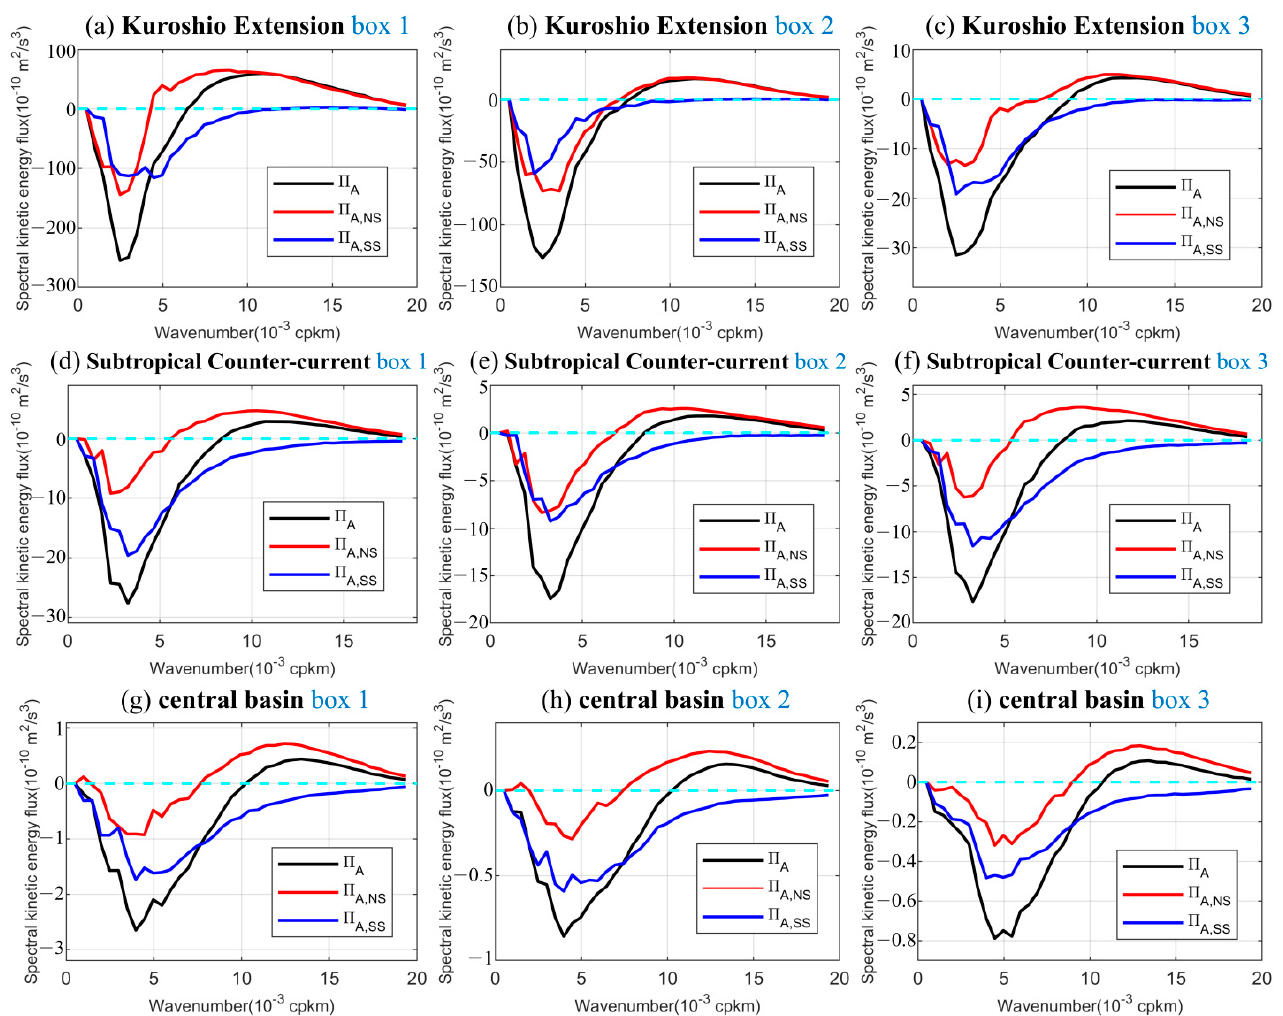
Figure 8. Time-mean of the total, normal-strain [ Π A, NS , Equation (24)], and shear-strain [ Π A, SS , Equation (25)] components to the spectral kinetic-energy flux Π A at a depth of 5 m in the nine regions from Figure 2. The title of each panel indicates the name of each region. No preprocessing of velocity is applied in this diagnosis.